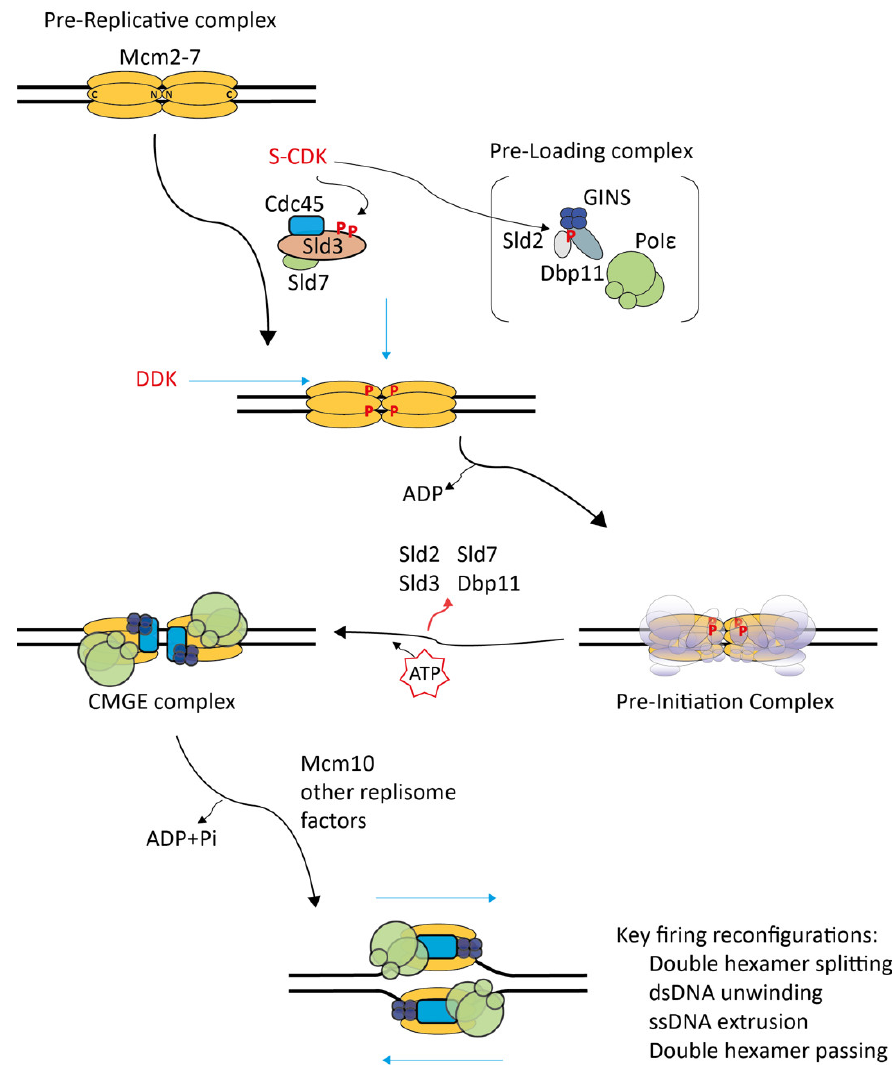
Figure 1. Schematic of eukaryotic replication initiation based on the budding yeast model. The first replication initiation step in the G1 cell cycle phase, licensing, loads the helicase-inactive pre-replicative complex (pre-RC) consisting of a head-to-head (N-domain to N-domain) Mcm2−7 double hexamer onto dsDNA. The second step in the S phase, origin firing, forms replisomes. DDK phosphorylates pre-RCs, recruiting Sld3-Sld7 and Cdc45. CDK phosphorylates Sld3 and Sld2, which then bind Dbp11. Sld2 forms the pre-loading complex with GINS and DNA polymerase ε (Pol ε) (brackets indicate uncertainties about complex arrangement). DDK-dependent pre-RC-recruited Sld3-Sld7, Cdc45, and pre-LC constitute the pre-initiation complex (low-lighting indicates structural uncertainties). Sld3-Sld7, Sld2 and Dbp11 dissociate, leaving behind the active CMGE helicase complex (Cdc45–Mcm2−7–GINS-DNA pol ε). Subsequent recruitment of other replisome factors completes the replisomes. The key molecular re-configurations to form replisomes from pre-RCs are the splitting of Mcm2–7 double hexamers, the melting of the dsDNA, the opening of the two Mcm2–7 rings to extrude the future lagging ssDNA strand, and the passing of the two CMGE